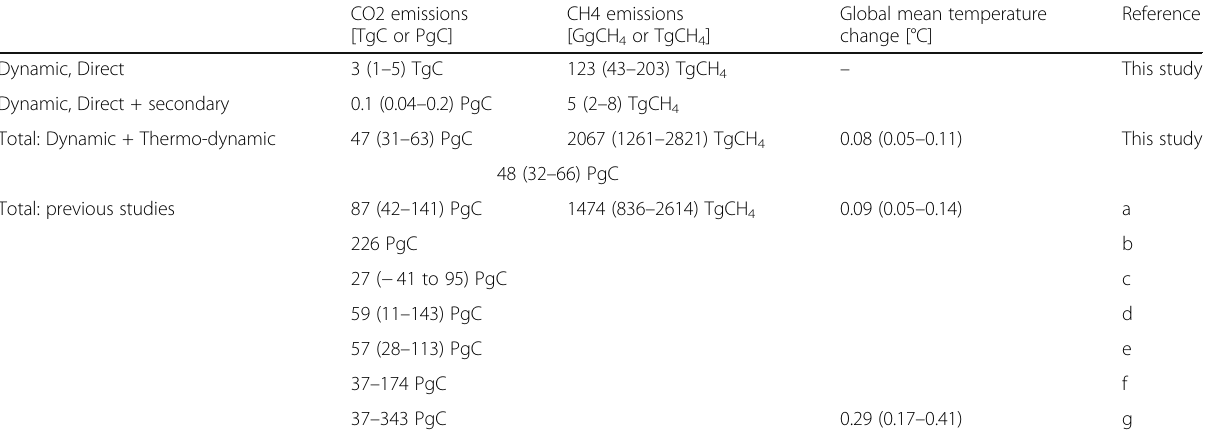
Table 3 Future predictions of GHG emissions from permafrost degradation in the RCP8.5